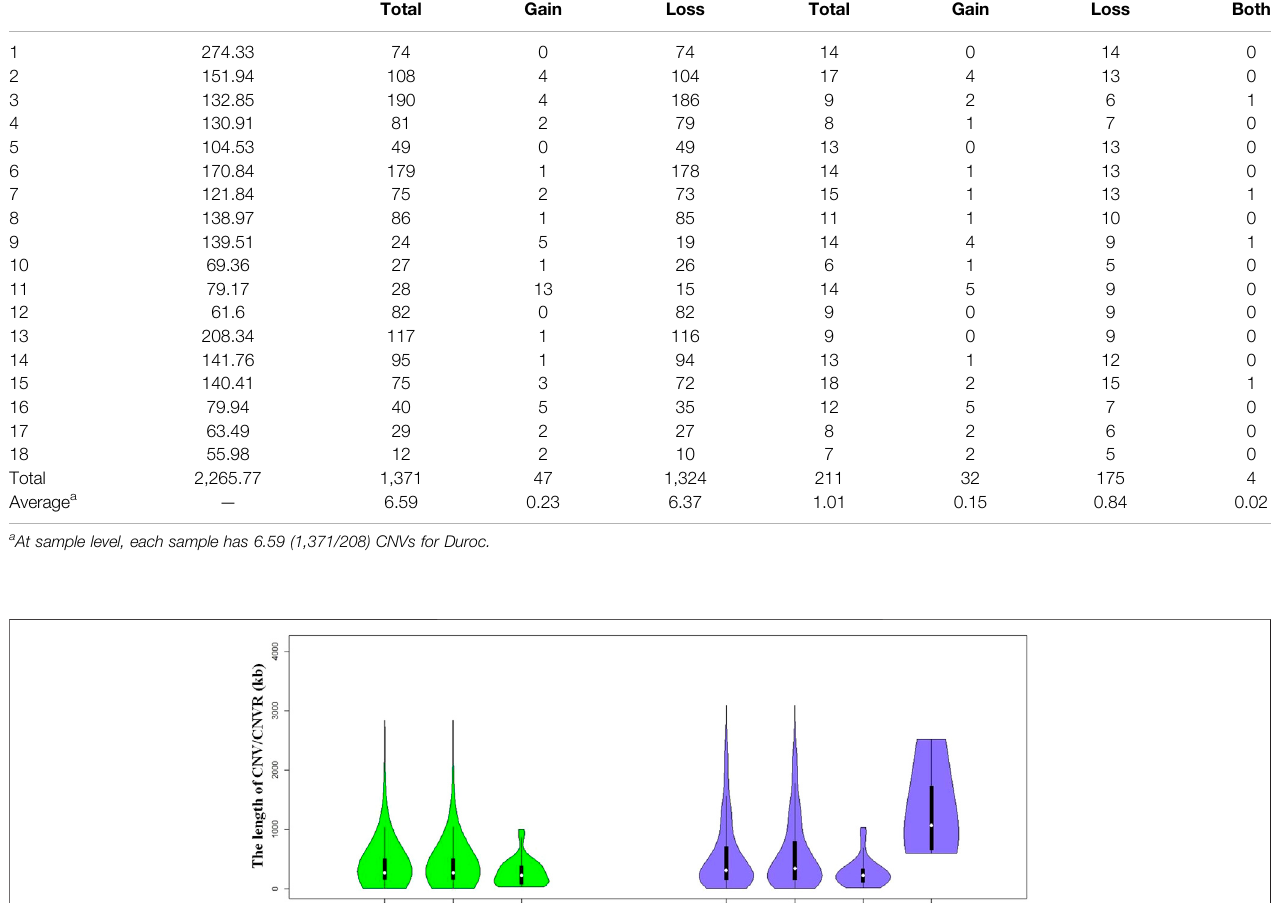
TABLE 1 | CNVR distributions in the each chromosome of Duroc purebred population. SSC